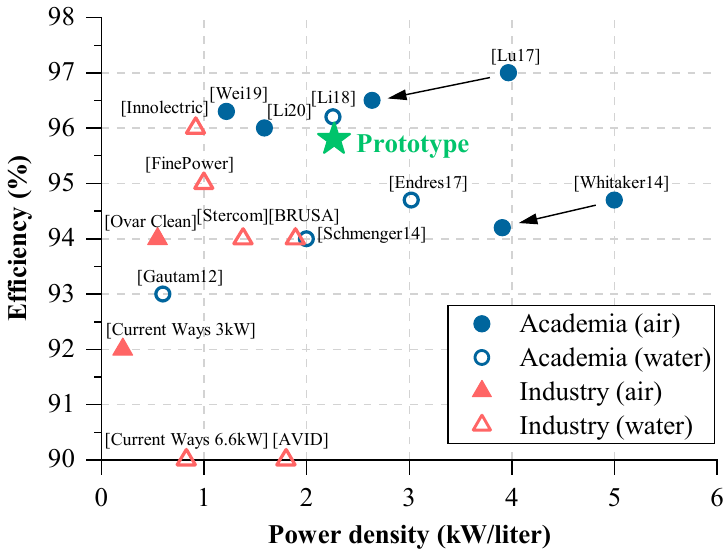
Figure 1. Overview of the state-of-the-art and prototype on-board chargers in terms of efficiency and power density. The shape of the symbol indicates the use of air- or water-cooling.